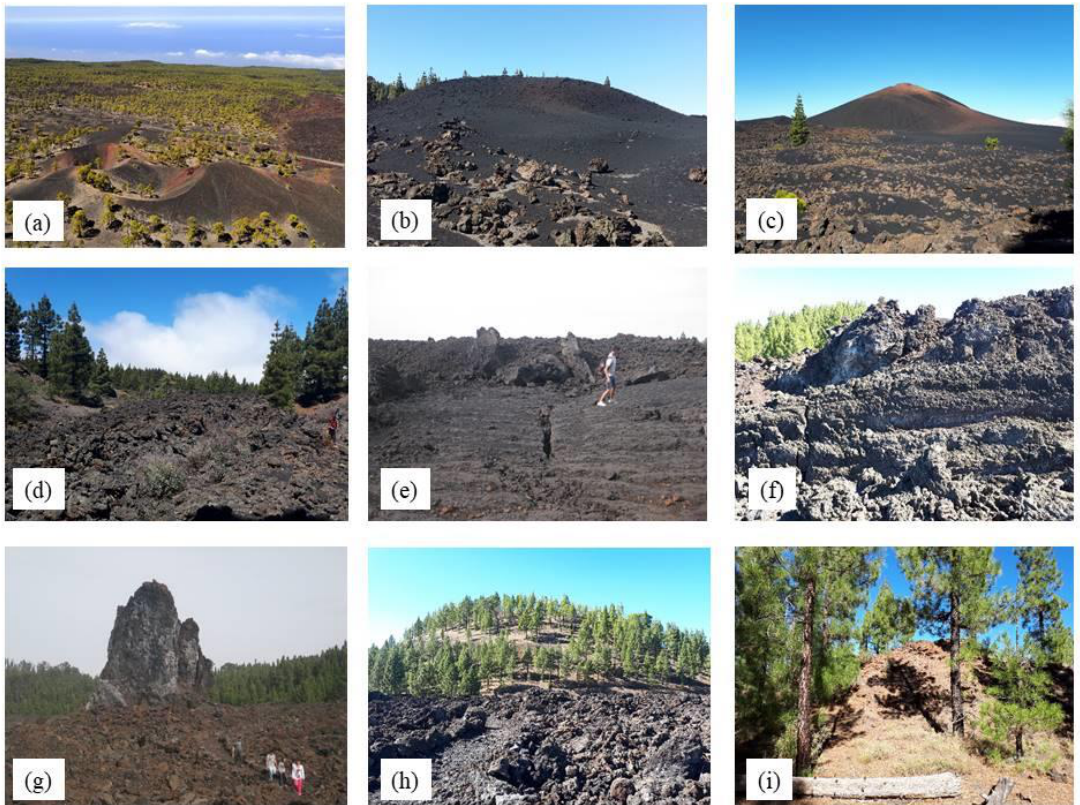
Figure 9. Different volcanic features and landforms of the Chinyero Nature Reserve. ( a ). Boca Cangrejo historical cinder cone and lava fields. ( b ). Small scoria cone of the Chinyero eruption. ( c ). Chinyero main cinder cone. ( d ). Montaña Reventada lava channel. ( e ). Pahoehoe lava flows from the Chinyero monogenetic volcano. ( f ). ‘Aa’ lava flows from the Chinyero eruption. ( g ). Erratic blocks in ‘aa’ lava flows from Chinyero. ( h ). Montaña de La Cruz monogenetic basaltic cone and ( i ). hornitos and spatter cones. Source: photo 1 http://www.fotosaereasdecanarias.com.